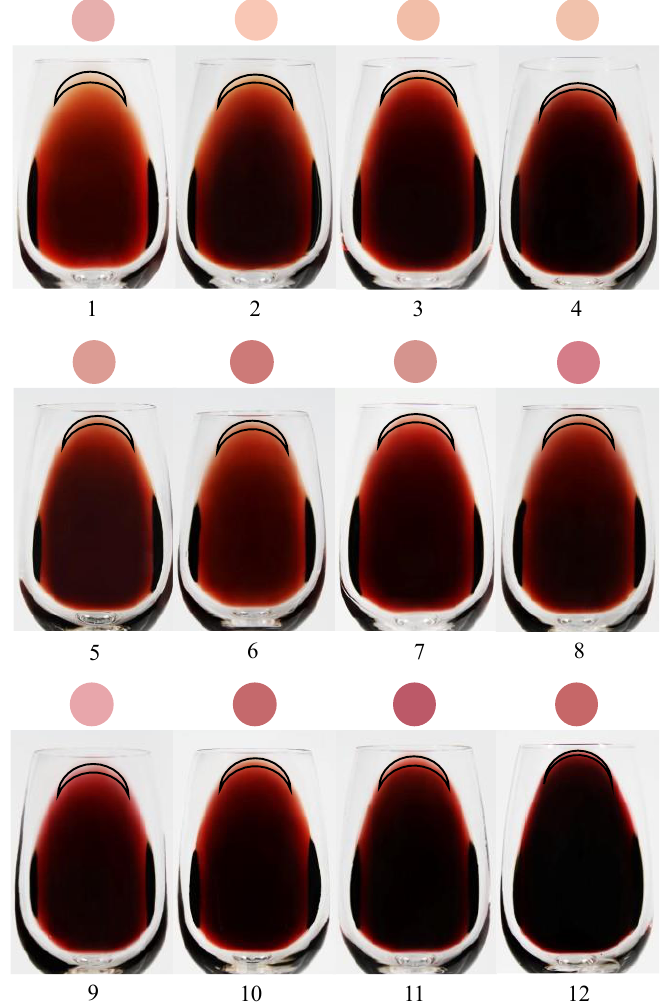
Figure 2. Comparison between the feature color and realistic photo of each wine sample.